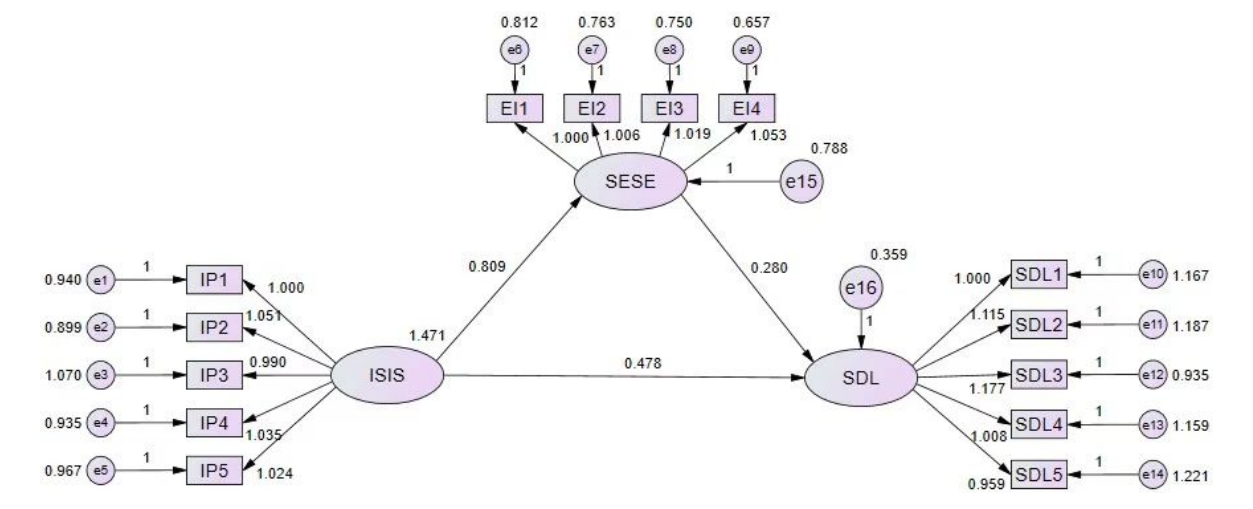
Figure 1. Research statistical model.